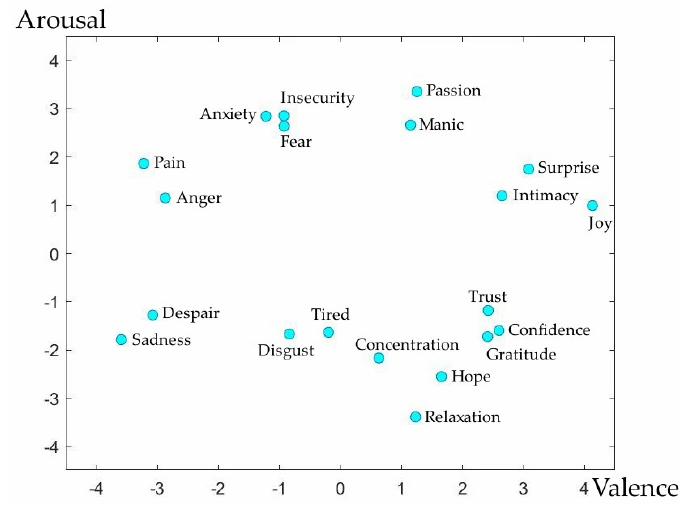
Figure 2. The 20 emotions in the valence arousal model.